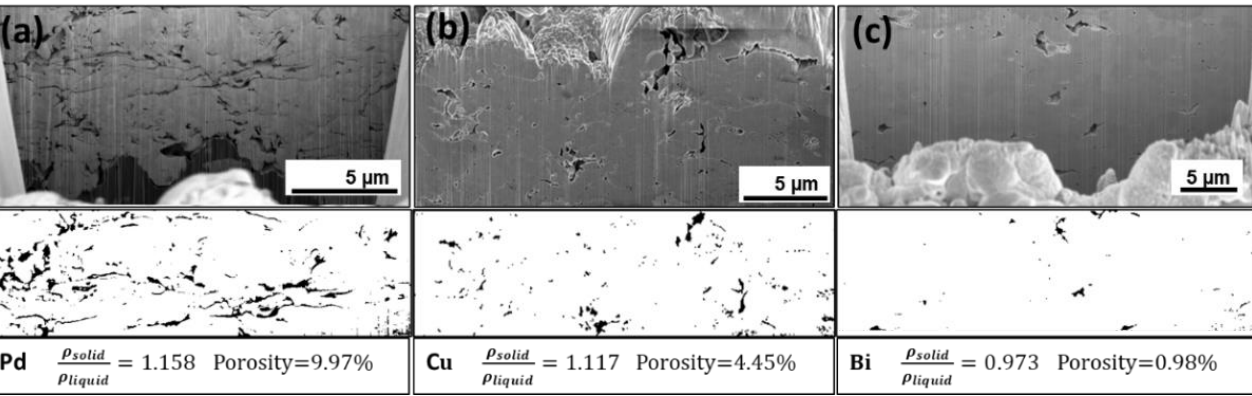
Figure 3. HR-SEM images of FIB cross-sections for LIFT printing on Si wafer of ( a ) palladium, ( b ) copper ( c ) bismuth